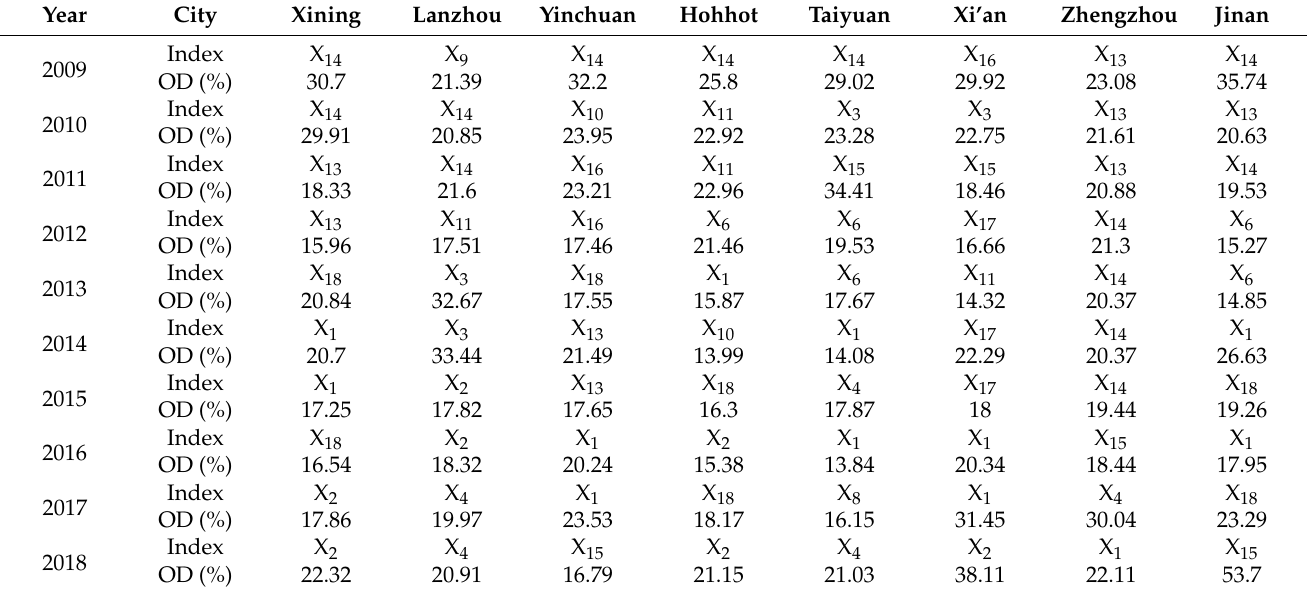
Table 6. Obstacle degree to SLU Indexes in Central Cities of the Yellow River Basin,